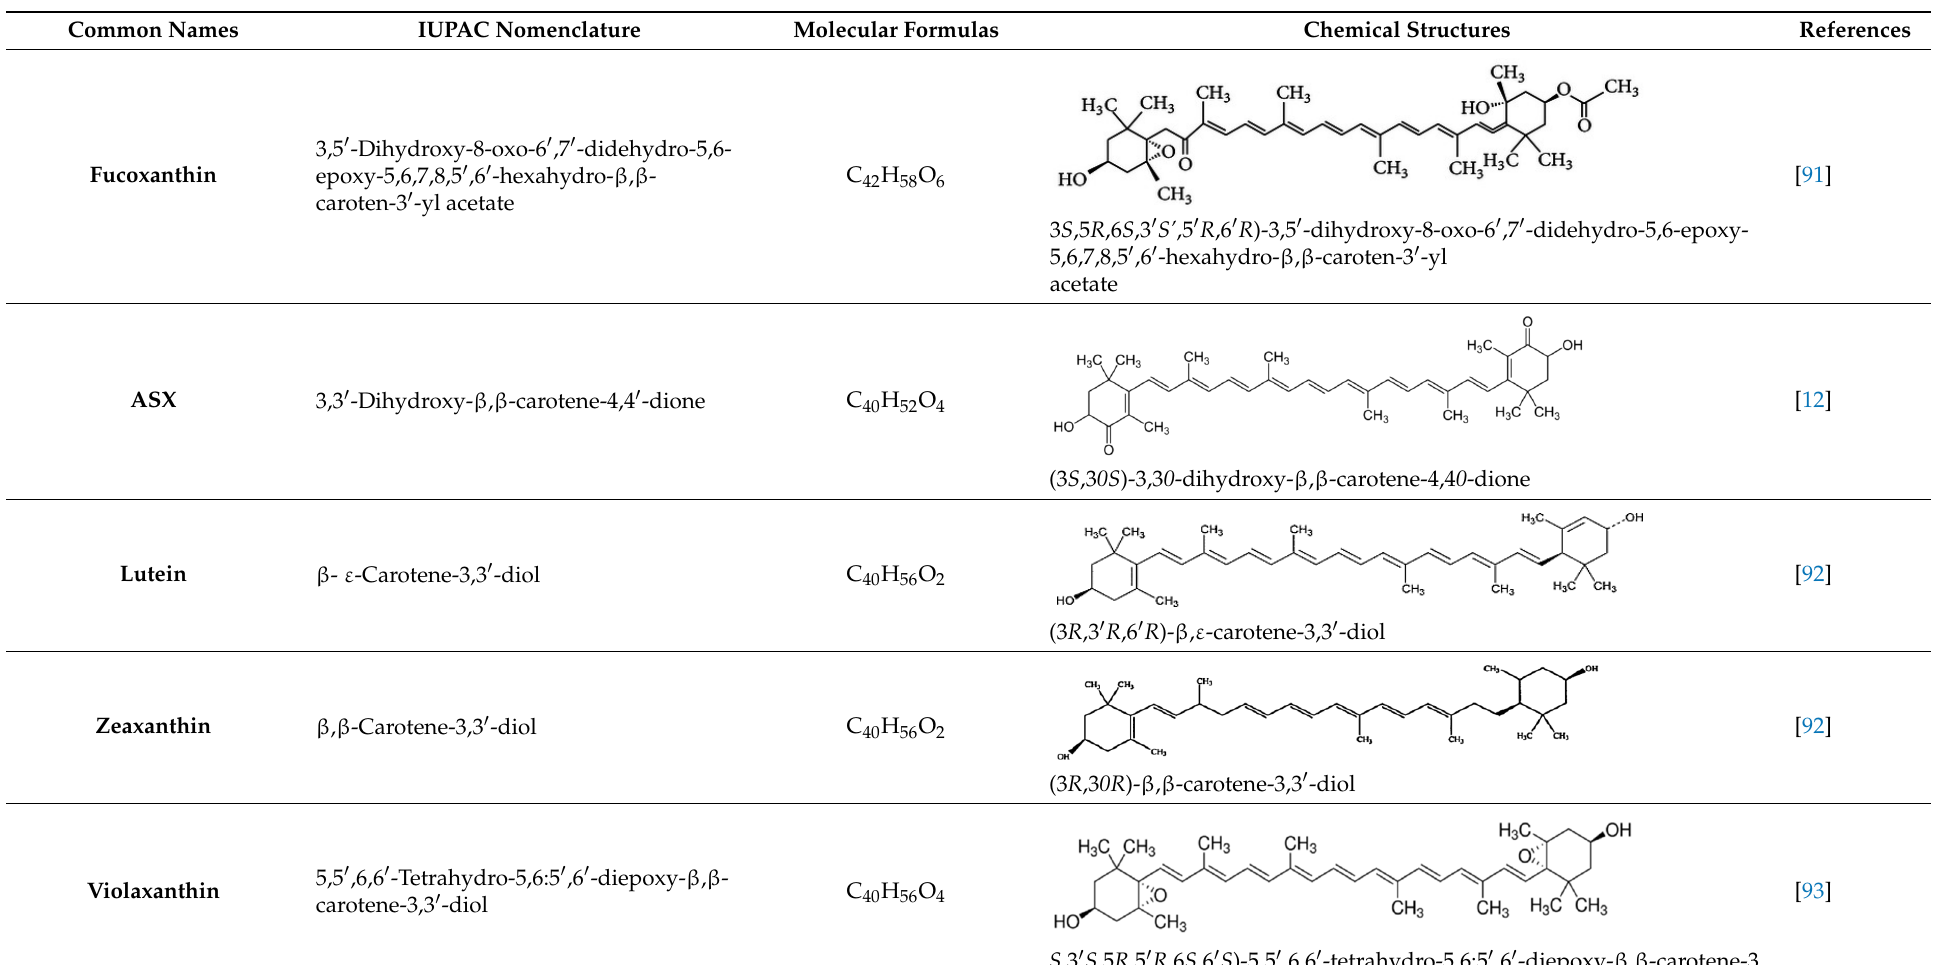
Table 2. Common names , IUPAC nomenclatures, molecular formulas and chemical structures of the most commercialized xanthophylls.